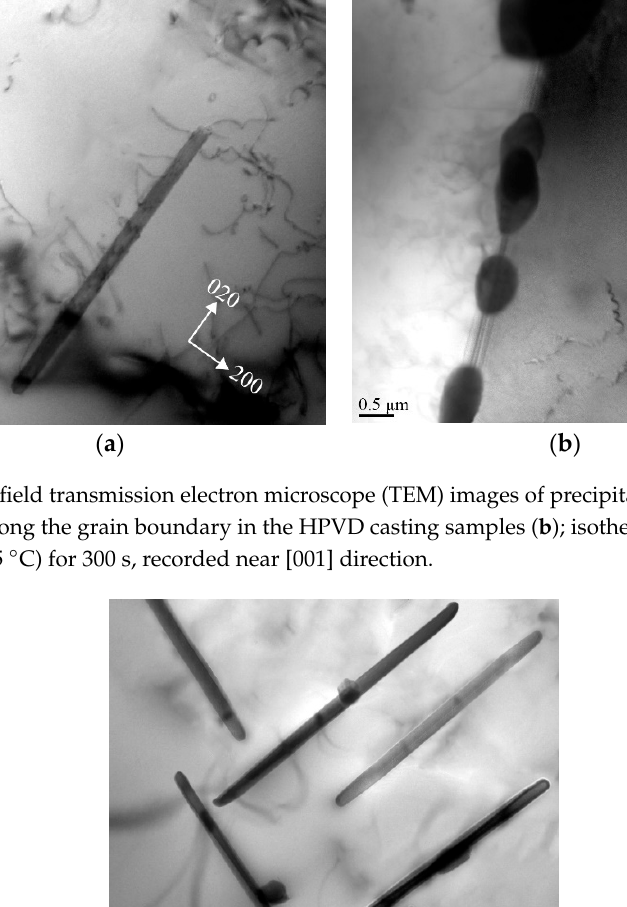
Figure 7. Effect of cooling rate on quench factor and predicted hardness ( a ) and a comparison between the measured data and predicted hardness decrease ( b ) of PM casting samples.